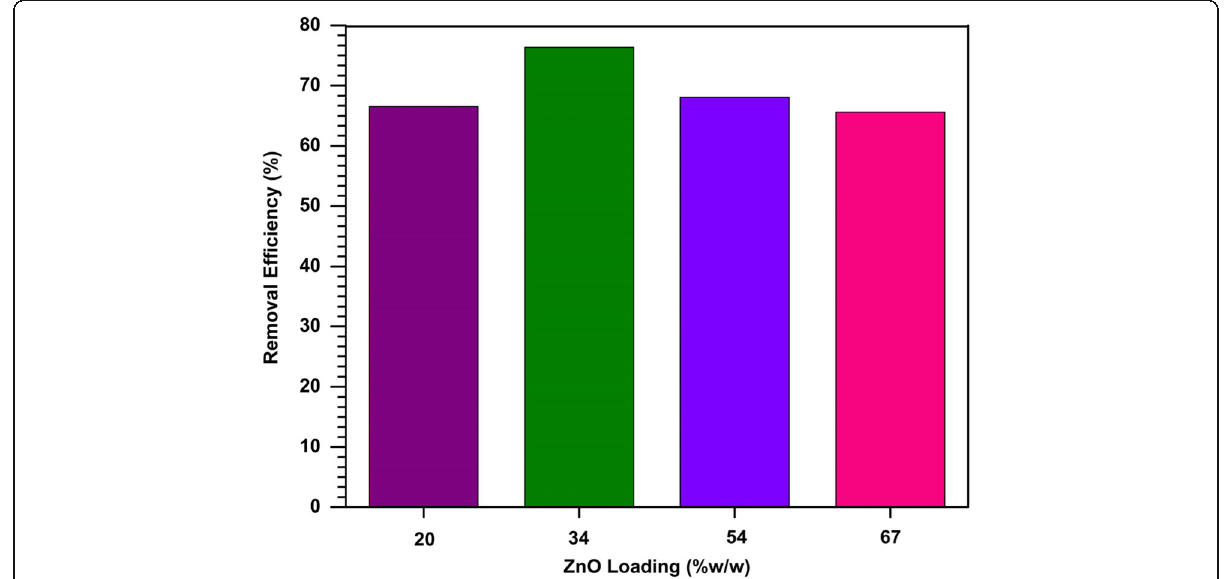
Fig. 8 Preliminary study of the effect of ZnO loading on ZSM-5 (C MB = 100 mg L − 1 , pH = 7, t = 60